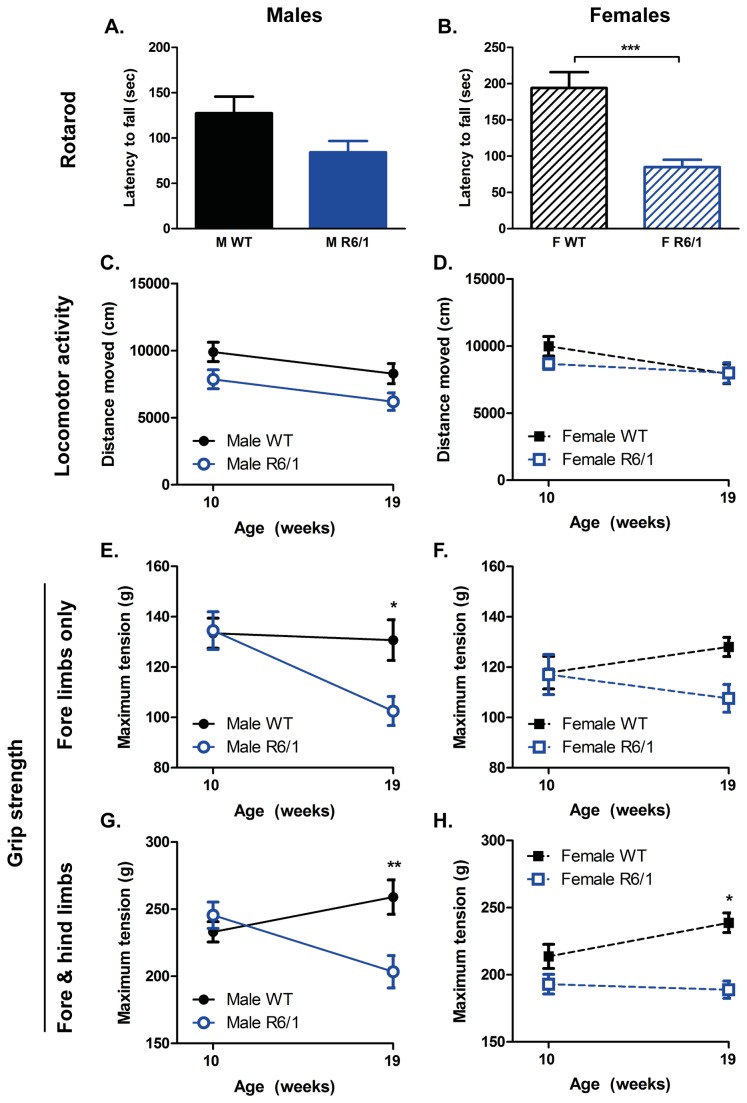
Performance at motor-related tasks.Both male (A) and female (B) R6/1 mice exhibited lower latency to fall from an accelerating rotarod at 11 weeks of age, reaching statistical significance in the females only. Conversely there was no difference in locomotor activity in an open field between WT and R6/1 mice at either 10 or 19 weeks of age (C & D). Forelimb grip strength (E & F) declined with age in R6/1 mice, as did both fore- and hind limb strength when taken together (G & H). Rotarod analyzed using two-way ANOVA (Genotype X Gender); locomotor activity and grip strength analyzed using three-way ANOVA (Genotype X Gender X Age). Rotarod: WT male n=11, R6/1 male n=9, WT female n=10, R6/1 female n=10; Locomotor activity: WT male n=11, R6/1 male n=9, WT female n=10, R6/1 female n=8-9; Grip strength: WT male n=11, R6/1 male n=9, WT female n=10, R6/1 female n=8-10. All data presented as means ± SEM; *p<0.05, **p<0.01, ***p<0.001.